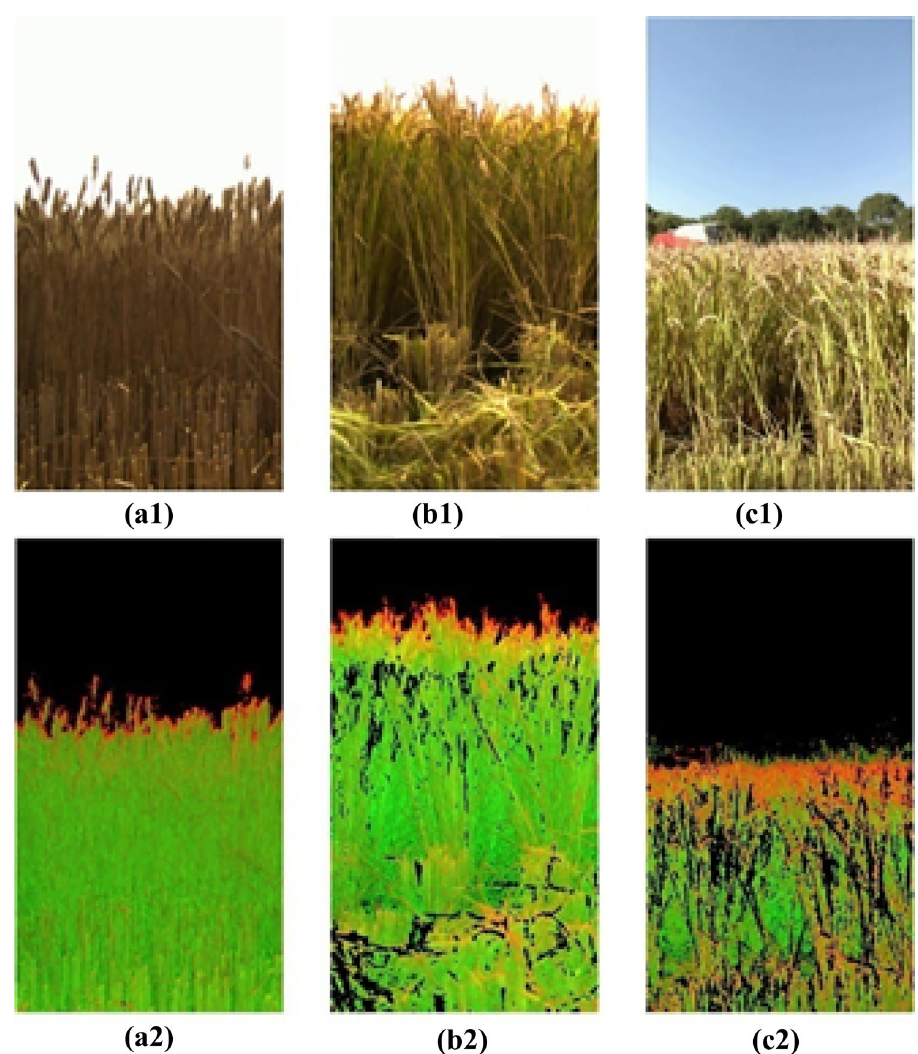
Fig. 4 Color-based feature